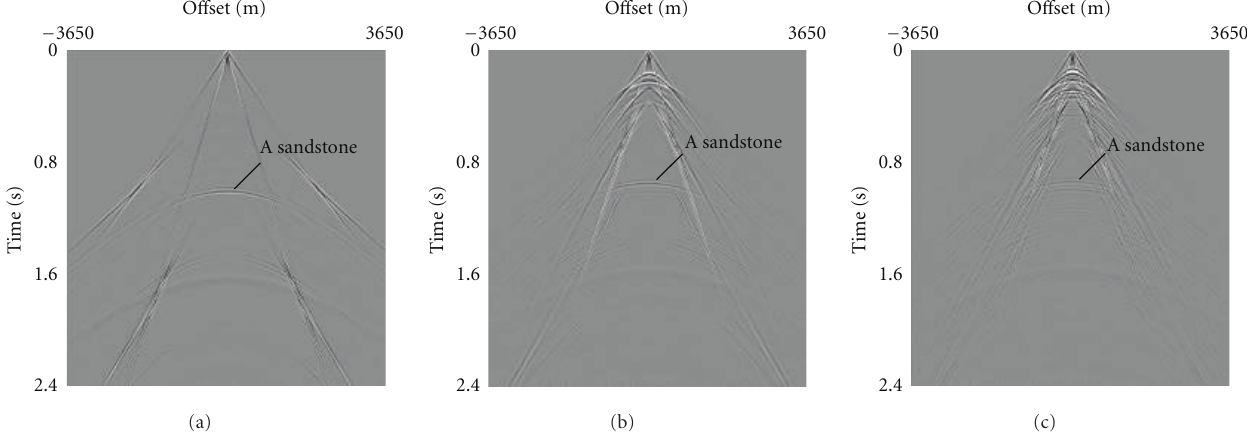
Figure 9: P-wave gather for the case of (a) Model 1a, (b) Model 1b, and (c) Model 1c, shows that the amplitude of multiples due to shallow anhydrite layers is comparable to the amplitude of primary reflections.